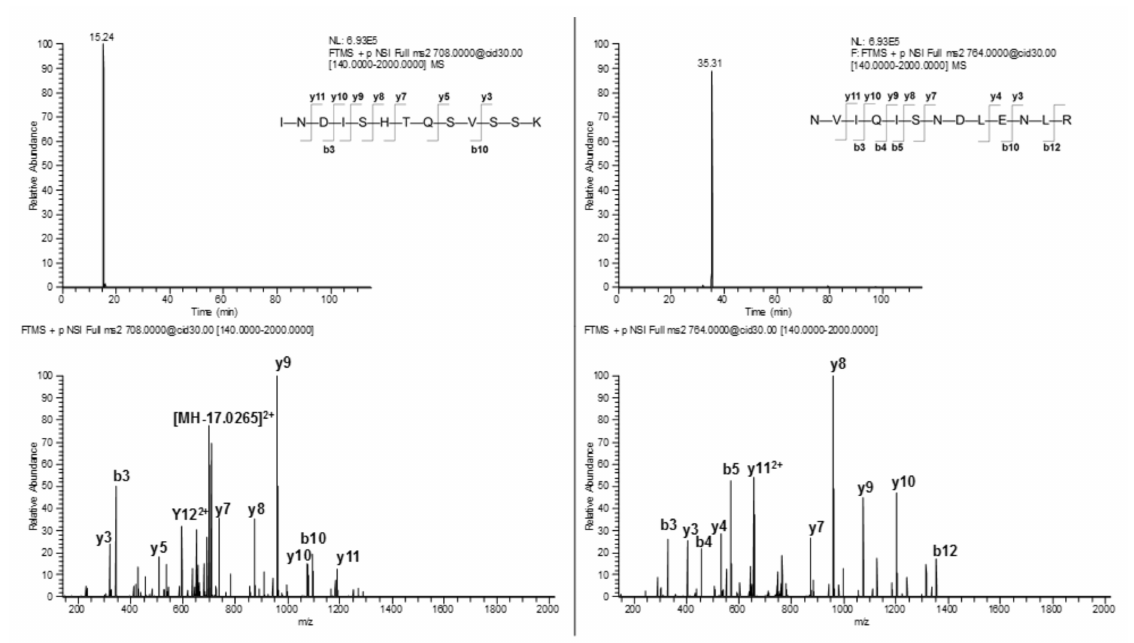
Figure 2. Chromatographic separation of human leptin analytical standard at concentration of 250 ng mL − 1 digested peptides and MS / MS fragmentation products of quantifier ( m / z = 708.3599, z = 2) and qualifier ( m / z = 764.4099, z = 2)